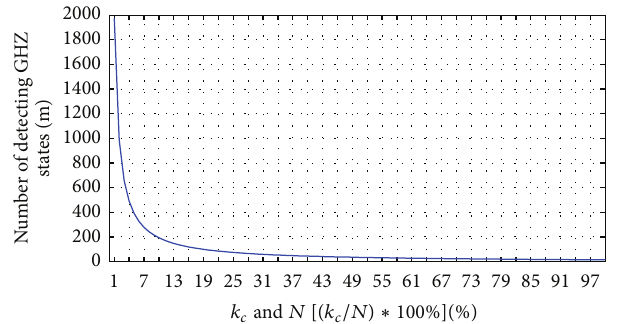
Figure 15: The legitimate users ensure quantum channel security with 100% probability corresponding to the number of detecting GHZ states and percentage of replaced GHZ